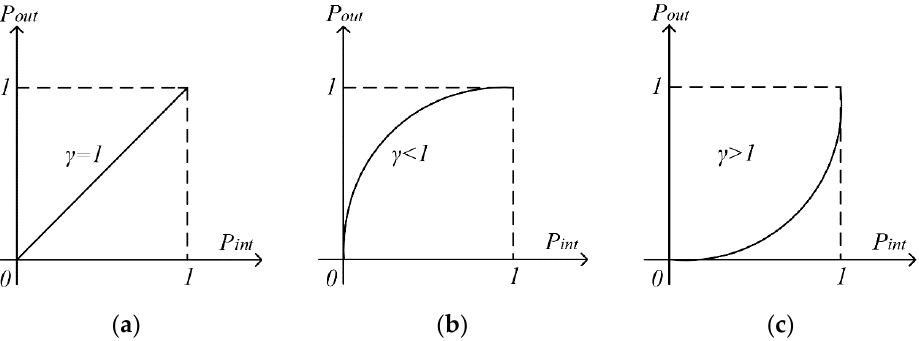
Figure 7. Gamma Correction Function Response, ( a ) GCF response with γ = 1, ( b ) GCF response with γ < 1, ( c ) GCF with γ > 1.